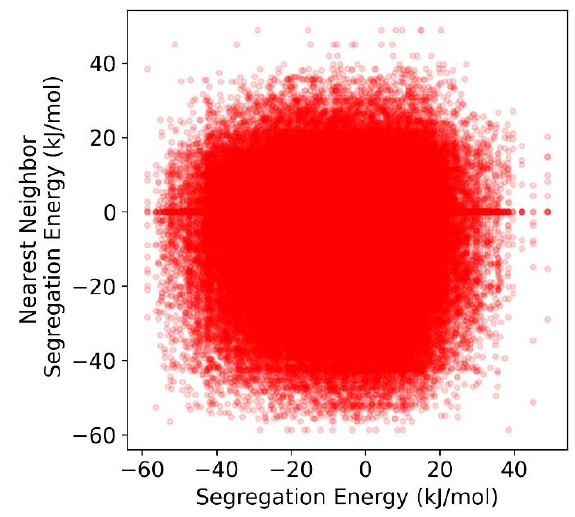
Figure 3. Correlation plot of the average segregation energy of the nearest neighbors of a given grain boundary site vs. the segregation energy of that site for Al-Mg in the (10 nm) 3